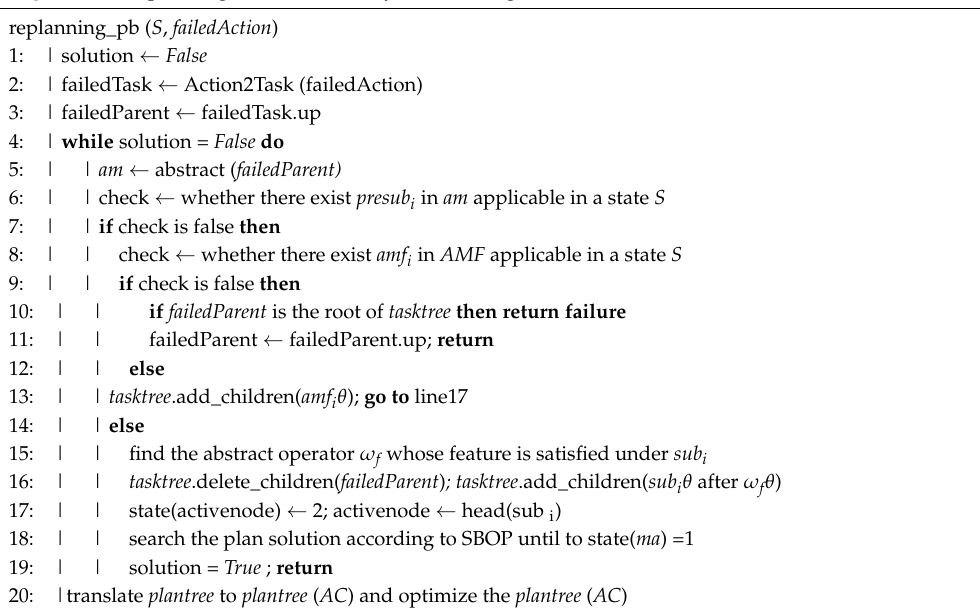
Figure 2. Basic principle of replanning based on partial backtracking. Red nodes are the failed actions. Red solid arrows represent the directions of a search; red dotted arrows are the function abstracts. Algorithm 3 Replanning Based on Partially Backtracking